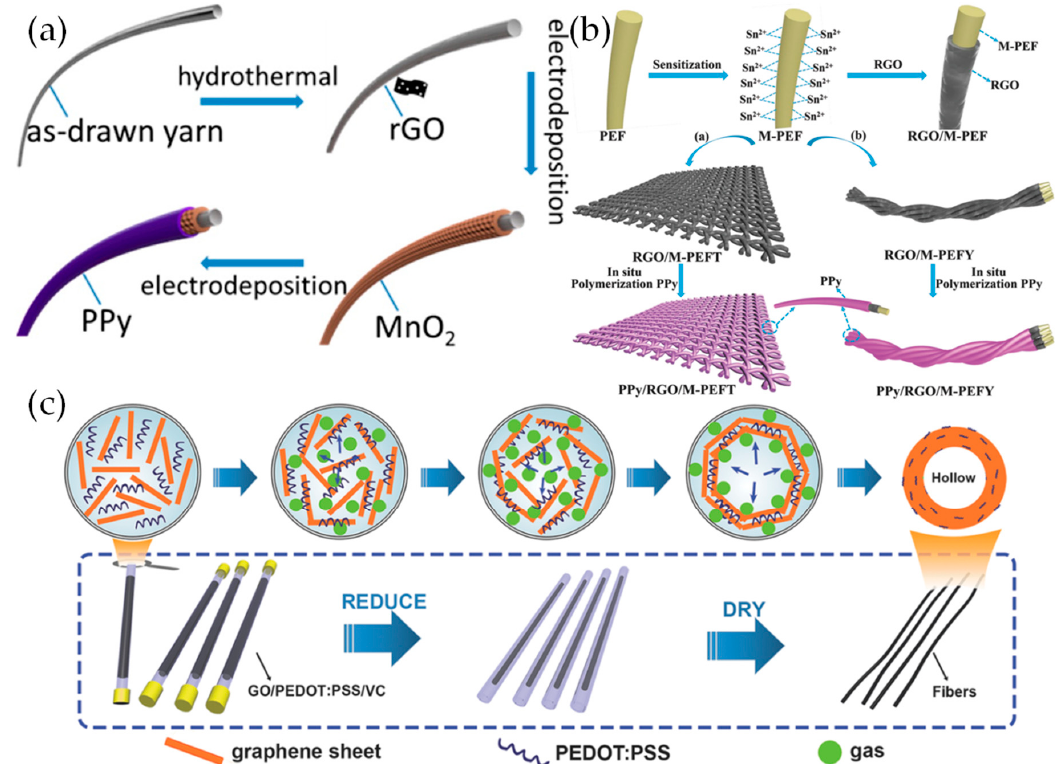
Figure 15. ( a ) Schematic illustration of the yarn modified by deposition of rGO, MnO 2 and PPy. Reproduced with permission from [137]. American Chemical Society (2015). ( b ) Schematic illustration of the synthesis route toward of textile electrodes and yarn electrodes. Reproduced with permission from [142]. Wiley (2018). ( c ) The preparation scheme for hollow structure composites. Reproduced with permission from [138]. Wiley (2016).